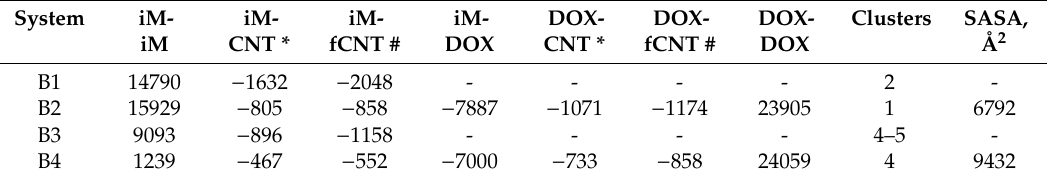
Figure 3. Optimal configurations of the systems B1–B4 found according to the scheme of rigid body replica exchange method followed by ca. 50 ns of unbiased calculations in NPT ensemble. Each iM molecule is displayed in di ff erent color in order to make the presentation clearer, DOX is shown as yellow spheres. The +/ − DOX and +/ − H( + ) arrows inform which change of the system state is done, i.e., incorporation / removal of DOX, application of protonated / unprotonated iM. Table 2. Mean pair interaction energies between various compounds determined from the last 10.8 ns of the simulations. The energies are given in kJ mol − 1 . The column ‘Clusters’ informs about the number of clusters formed by iM molecules (fCNT and DOX molecules are not included in cluster analysis). SASA is the solvent accessible surface area calculated for DOX